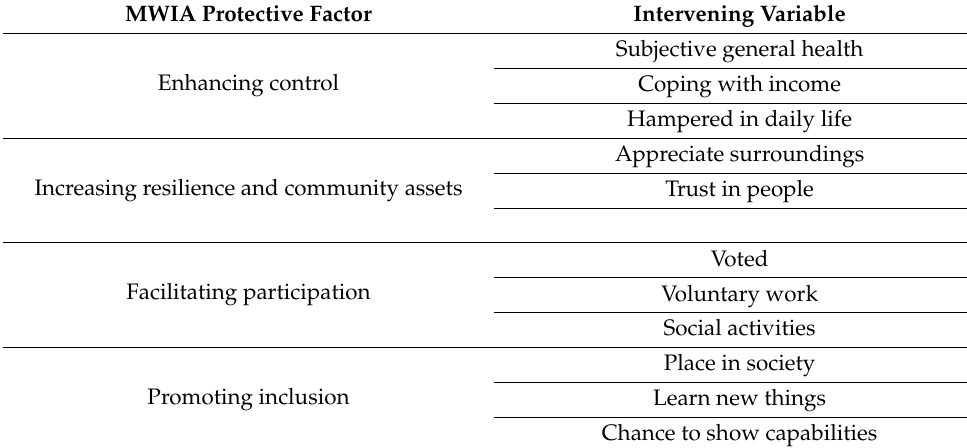
Table A2. Intervening variable allocation into MWIA protective